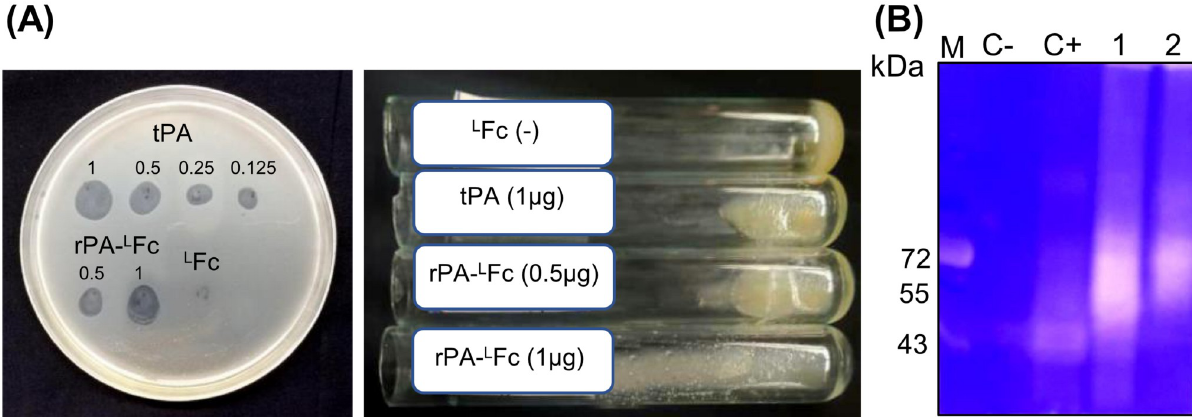
Fig 8. Functional assays of rPA-Fc fusions expressed in Δ XF plants. (A) The proteolytic activity of rPA- L Fc was assessed by clot lysis assay. Clotted blood plasma was poured on Petri dishes (left) or in glass tubes (right) and purified rPA- L Fc was spotted at different concentrations ( μ g). tPA (Alteplase) was used as a positive control and Fc as a negative control. Fibrin digestion can be visualized by grey spots (left panel) or solubilized plasma (right panel). (B) Plasminogen zymography of purified plant-derived rPA-Fc. Staining of 8% SDS-PAGE with Coomassie brilliant blue shows the proteolytically cleaved sites as white clear smears on a dark blue background. 1. rPA-mFc and 2. rPA- L Fc. Proteolytic activity is also observed on the positive control, (C+, Alteplase) but not on the negative control (C-, IgG1). Protein size markers are shown in kilo Dalton (kDa).